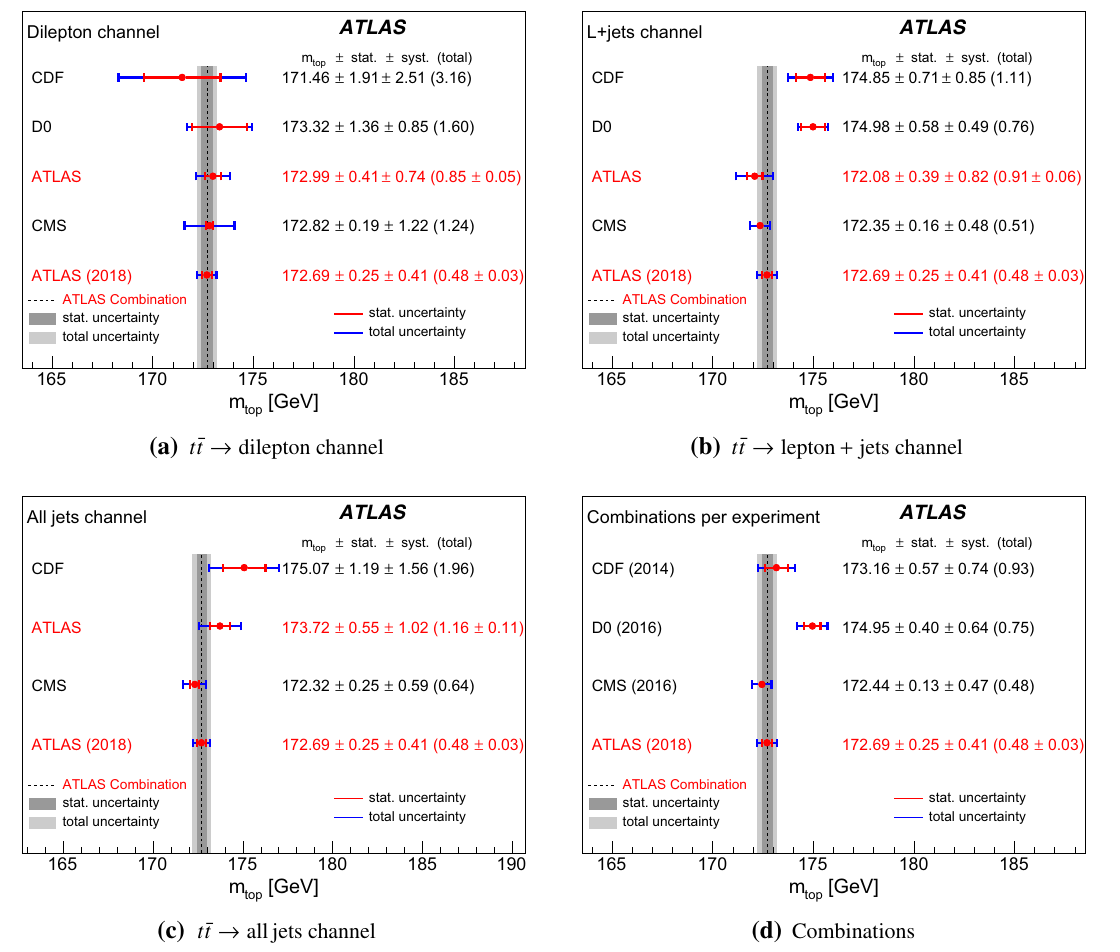
Fig. 14 The most precise result of m top per experiment in the dif- ferent t ¯ t decay channels and m top from the latest combinations per- formed by the individual experiments. a shows the measurements in the t ¯ t → dilepton channel, b shows those in the t ¯ t → lepton + jets and c shows the ones in the t ¯ t → alljets channel. d shows the results of m top from the latest combination per experiment. In all figures the vertical band corresponds to the new ATLAS combined value of m top .